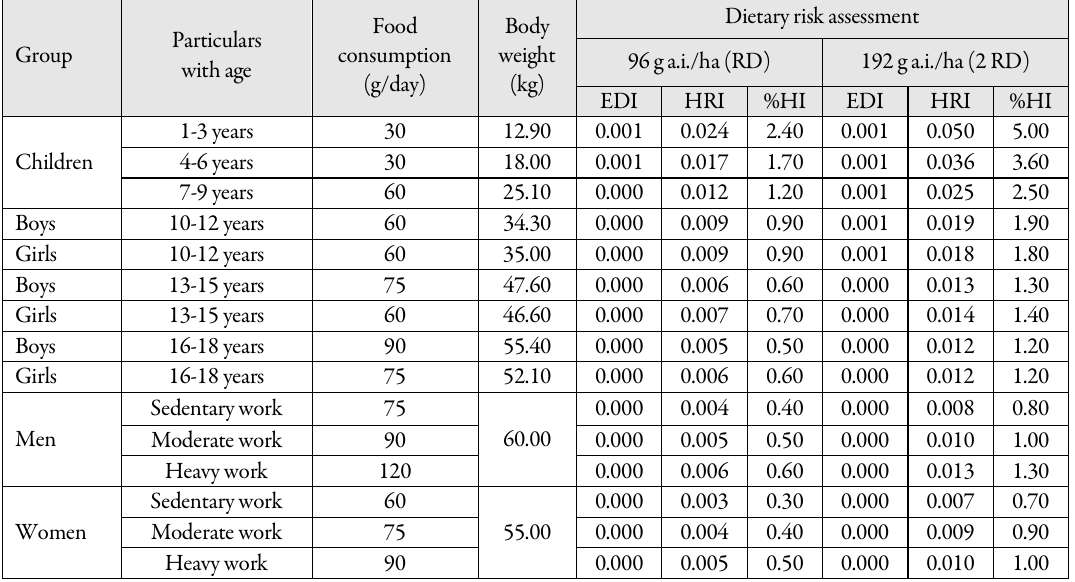
Table 3. Health risk assessment of spiromesifen in brinjal for different groups of Indian consumers